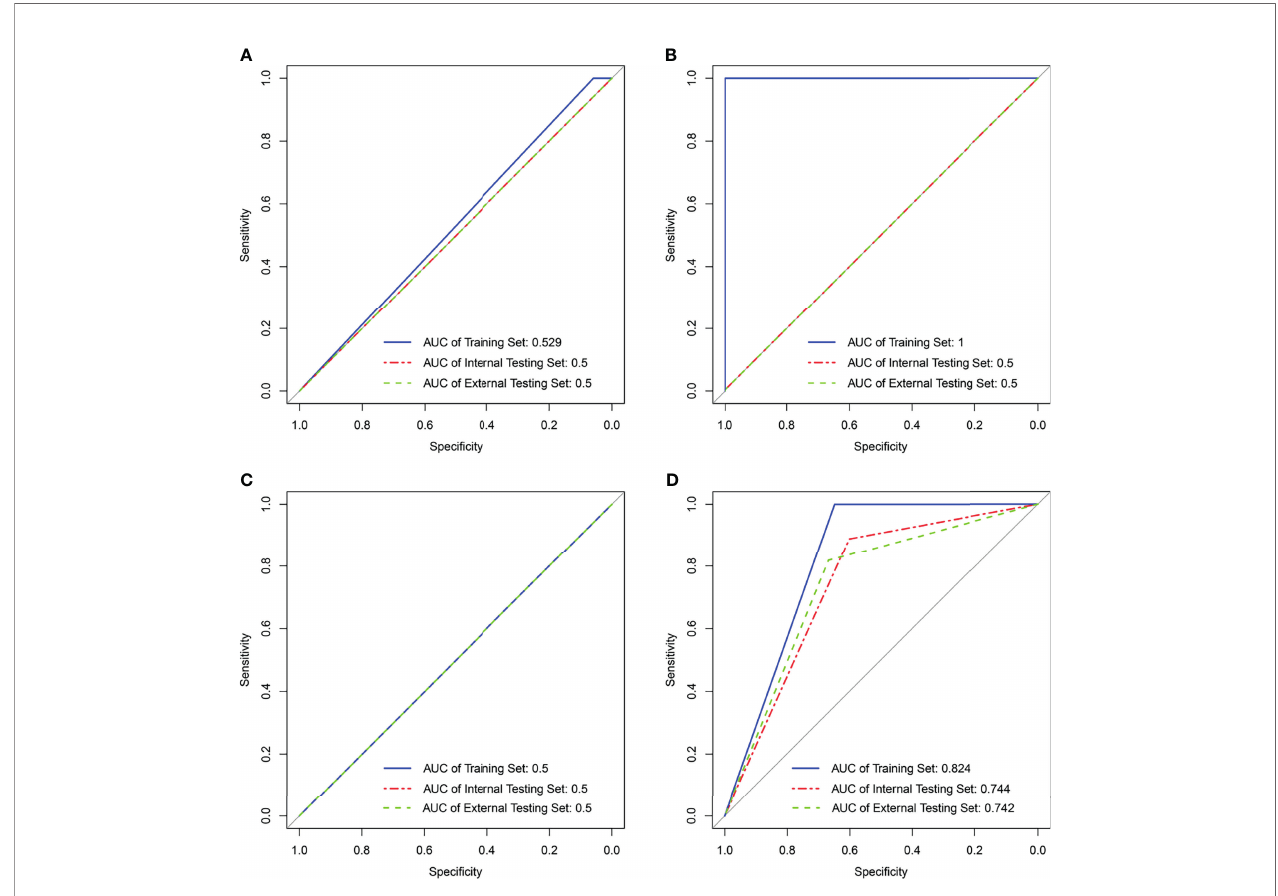
FIGURE 3 | Results of support vector machine classi fi er in the training, internal, and external testing sets with four kinds of radiomics features. (A) Result of SVM generating radiomics signature pretreatment . (B) Result of SVM generating radiomics signature 1st week . (C) Result of SVM generating radiomics signature 2nd week . (D) Result of SVM generating radiomics signature 2 weeks . NA in (B, C) means not